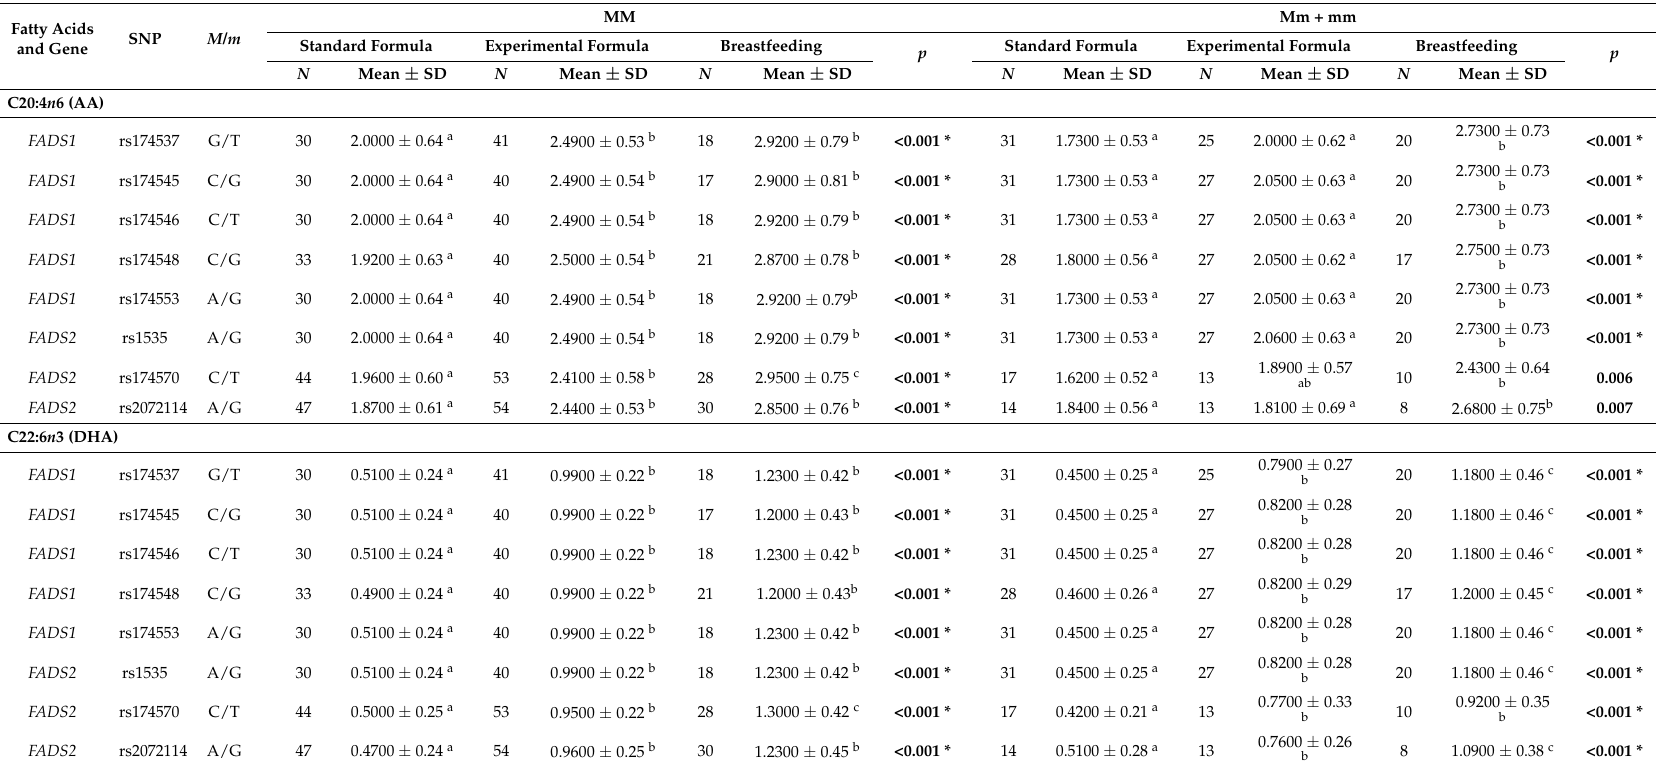
Table 4. Fatty acids according to infant SNPs and study